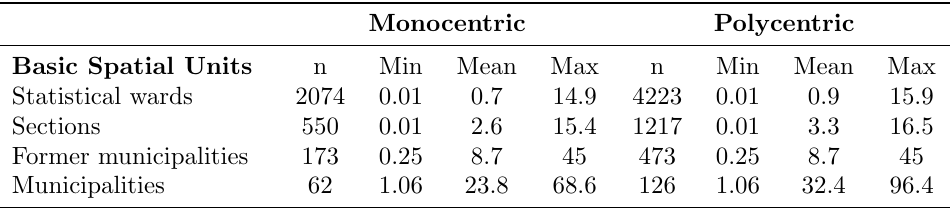
Table 1: Descriptive statistics of the BSU per case study